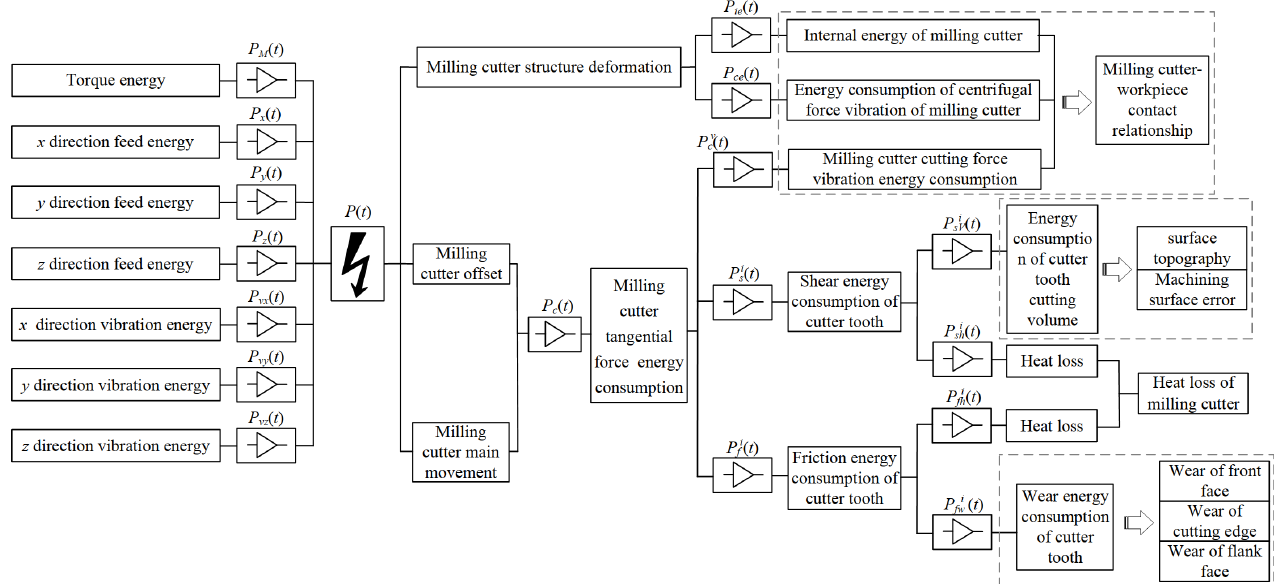
Figure 2. Energy transfer and transformation in milling process of milling cutter.